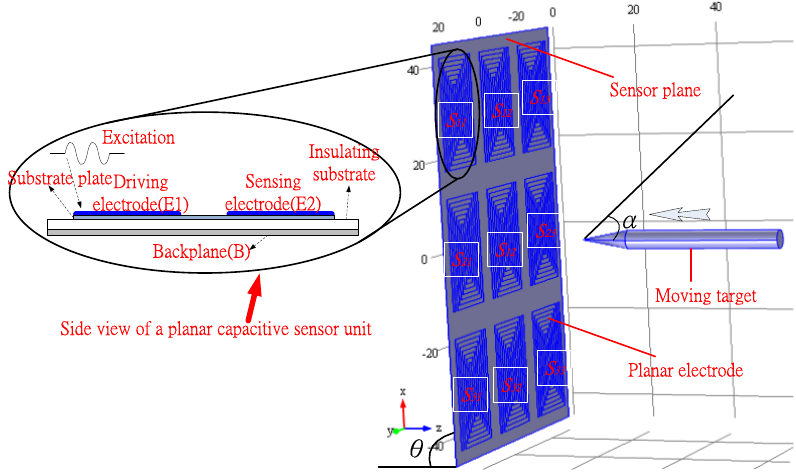
Figure 1. Schematic of the planar capacitive sensors system (PCSS) structure.